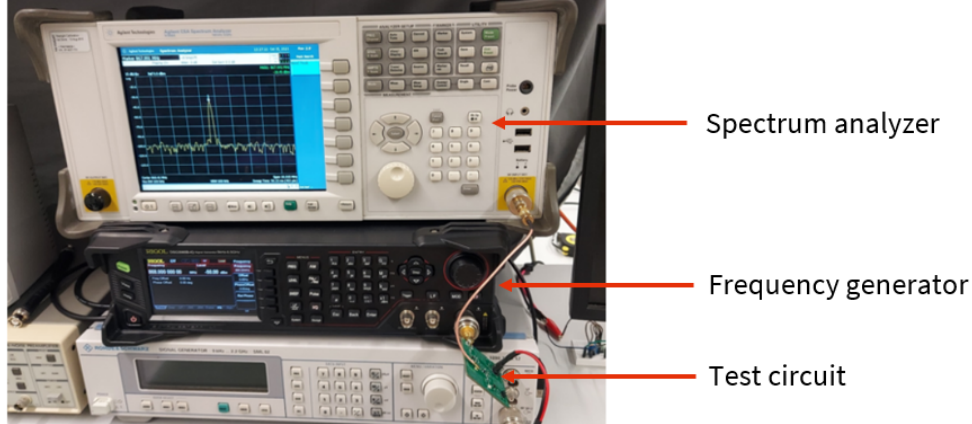
Figure 13. Measurement setup for measuring amplifier gain, compression point and linearity.